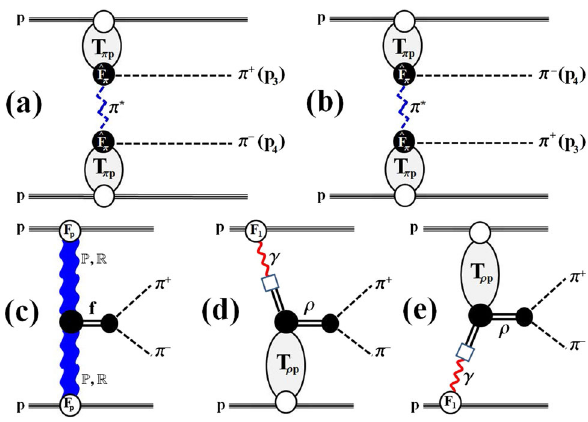
Fig. 1 Primary amplitudes (absorptive corrections are not shown) of the process of double-pion LM CEDP p + p → p + π + + π − + p in the Regge-eikonal approach for a continuum ( a , b ), LM CEDP of f 0 and f 2 resonances ( c ) and EVMP of a ρ 0 meson ( d , e ) with subsequent decay to π + π − . a , b The central part of the diagram is the primary continuum CEDP amplitude, where T π ± p are full elastic pion–proton amplitudes, and the reggeized off-shell pion propagator is depicted as a dashed zigzag line. This is the most applicable case from the four approaches considered in [3]. c The central part of the diagram contains pomeron–pomeron-resonance fusion with subsequent decay to pions. The propagator is taken in the Breit–Wigner approximation. d , e The central part of the diagram contains full EVMP amplitude with ρ 0 production and decay. Off-shell pion form factor on a , b and other suppression form factors (in the pomeron–pomeron-f or the pion–pion- ( f 0 , f 2 , ρ 0 vertices) ) on c – e are presented as black